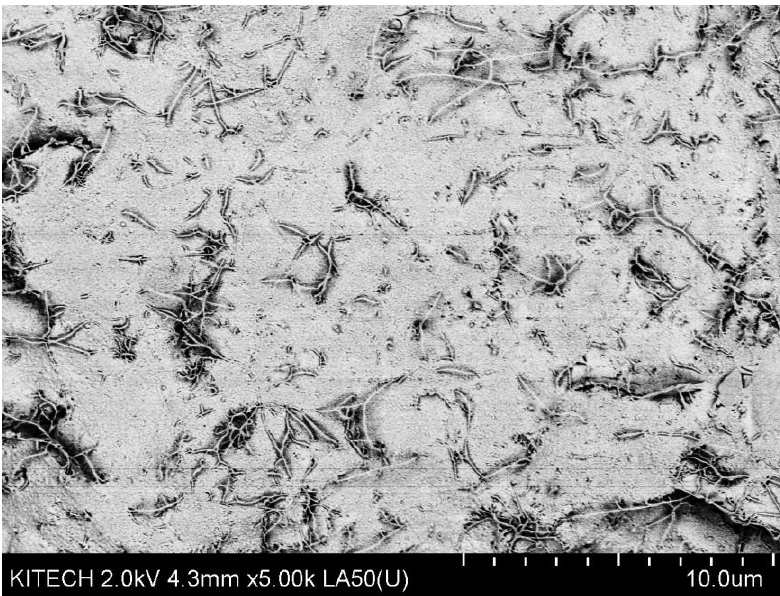
Figure A2. SEM image of the 0.62 wt.% SWNT/PP composite.